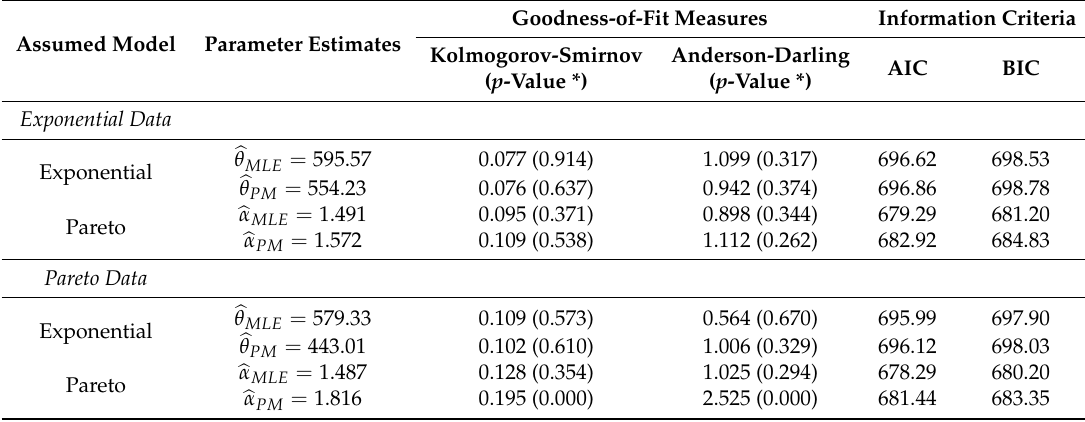
Table 2. Parameter estimates, goodness-of-fit measures, and information criteria for the exponential and Pareto models fitted to the data sets of Table